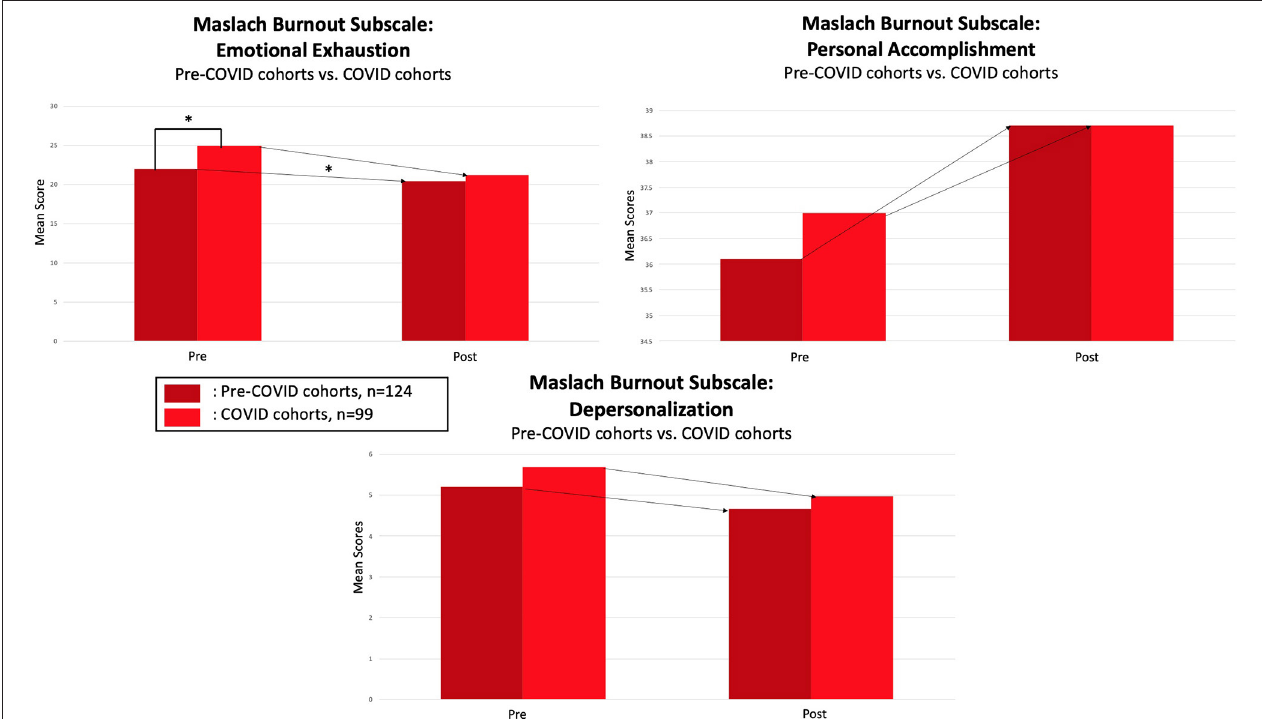
FIGURE 2 | Pre-COVID vs, COVID cohort comparisons on MBI subscales (*denotes significant p -value, p < 0.05).